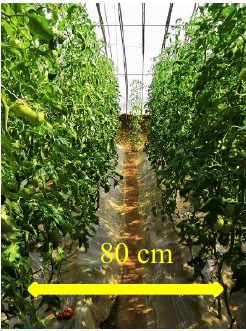
Figure 5. Inter-ridge distance of tomatoes cultivated in the greenhouse.